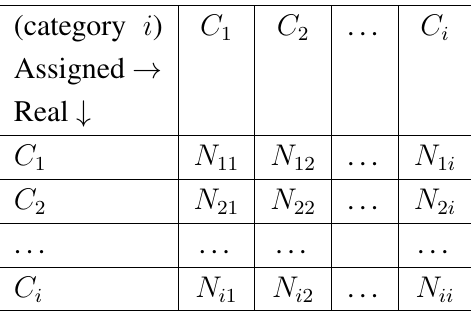
Table 2. Confusion matrix for more than 2